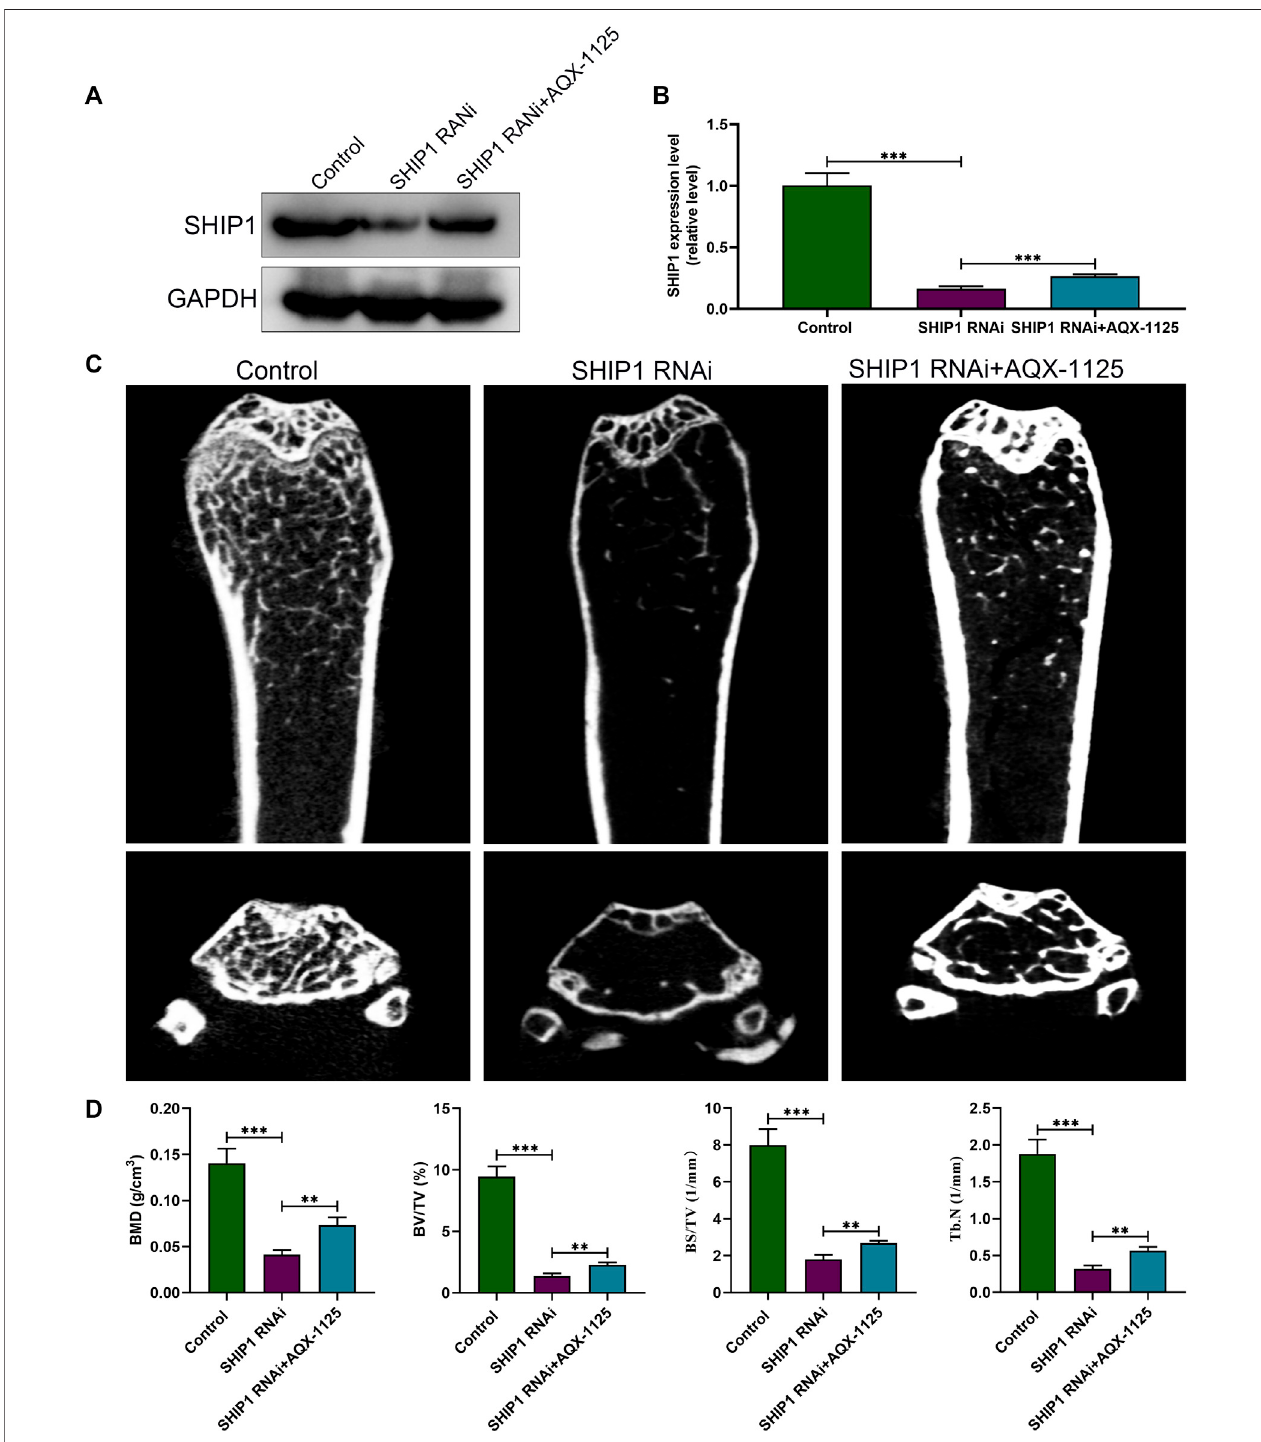
FIGURE 7 | SHIP1 RNAi administration induces bone loss. (A) Protein expression level of SHIP1 in femurs after exposure to treatment. Eight-week-old male C57 mice were retreated with vehicle (control group), SHIP1 RNAi (5 nm/20 g), and SHIP1 RNAi (5 nm/20 g) +AQX-1125 (10 mg/kg) for 4 weeks. Total protein was isolated from femurs of each group, and Western blotting was performed. (B) Quantitative analysis of each immunoblot in (A) . (C) Micro CT analysis of the distalfemurs from the control, SHIP1 RNAi, and SHIP1 RNAi + AQX-1125 group. (D) Calculation of the BMD, BV/TV, BS/TV and Tb.N. Data are presented as means ± SD from three independent experiments (* p < 0.05; ** p < 0.01; *** p < 0.001).